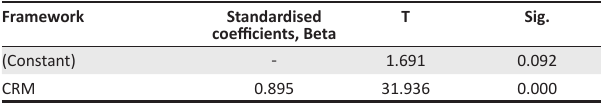
Two-way communication